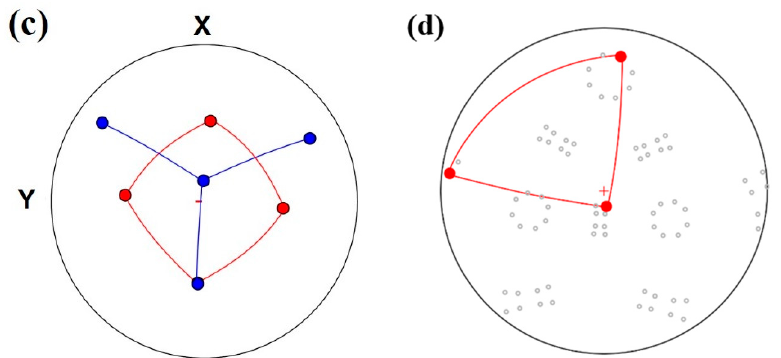
Figure 7. EBSD results on the plane normal to the growth direction for 45 ◦ oriented sample. ( a ) image quality, ( b ) corresponding orientation image (IPF-z), ( c ) {111} γ pole figure of two twin related variants in ( b ), ( d ) {001} β pole figure showing reconstructed orientation of β phase based on orientation relationship.